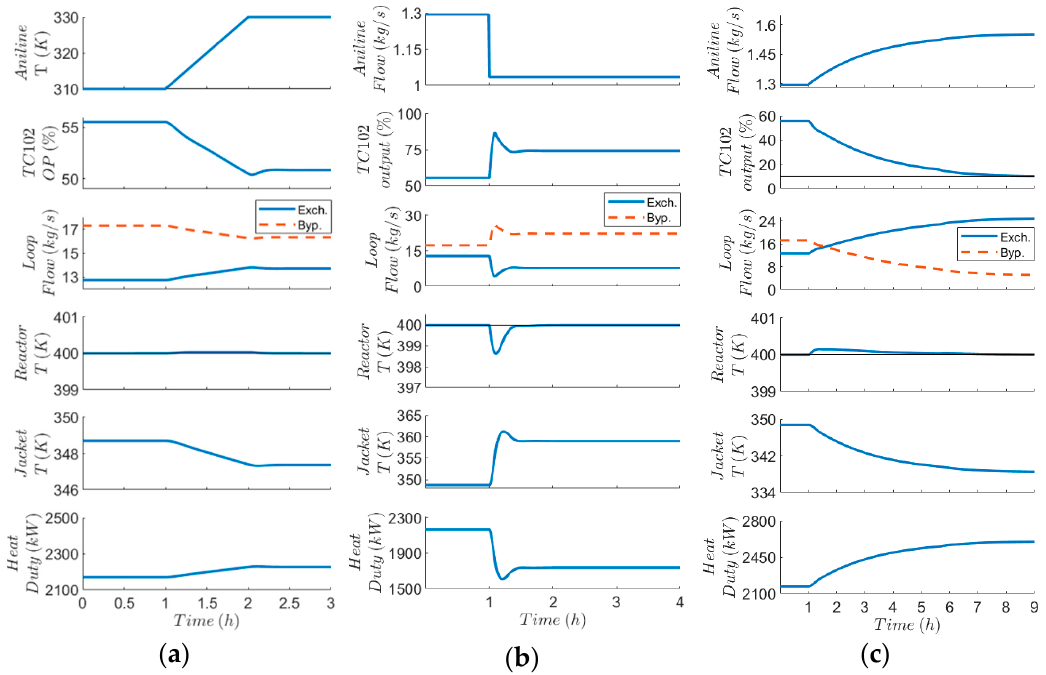
Figure 11. Control performance of plant Design D1 under ( a ) Scenario 1, ( b ) Scenario 2, and ( c ) Scenario 3.